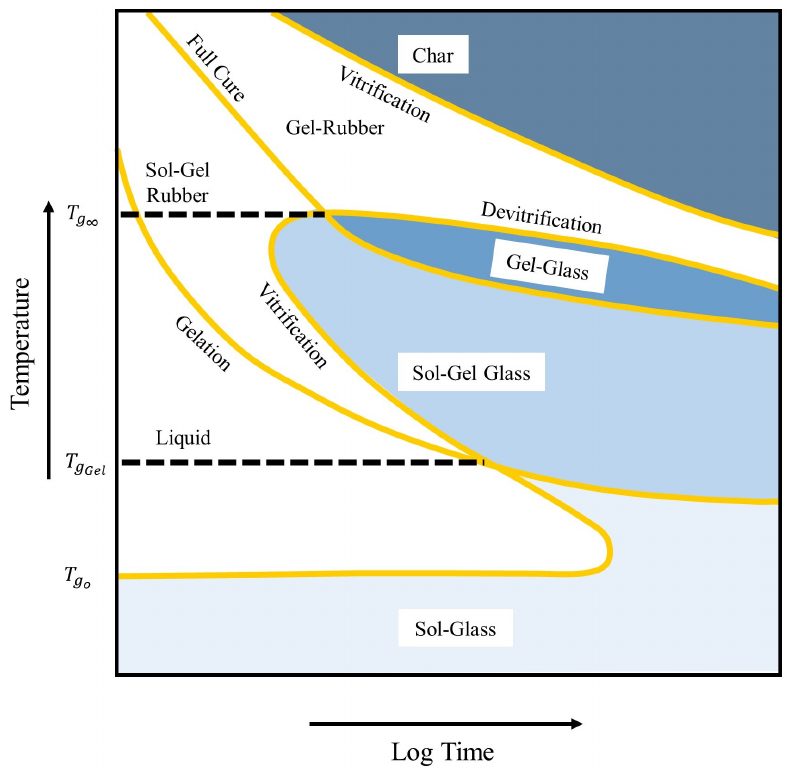
Figure 1. A schematic diagram for time–temperature–transformation (TTT) cure of resin systems